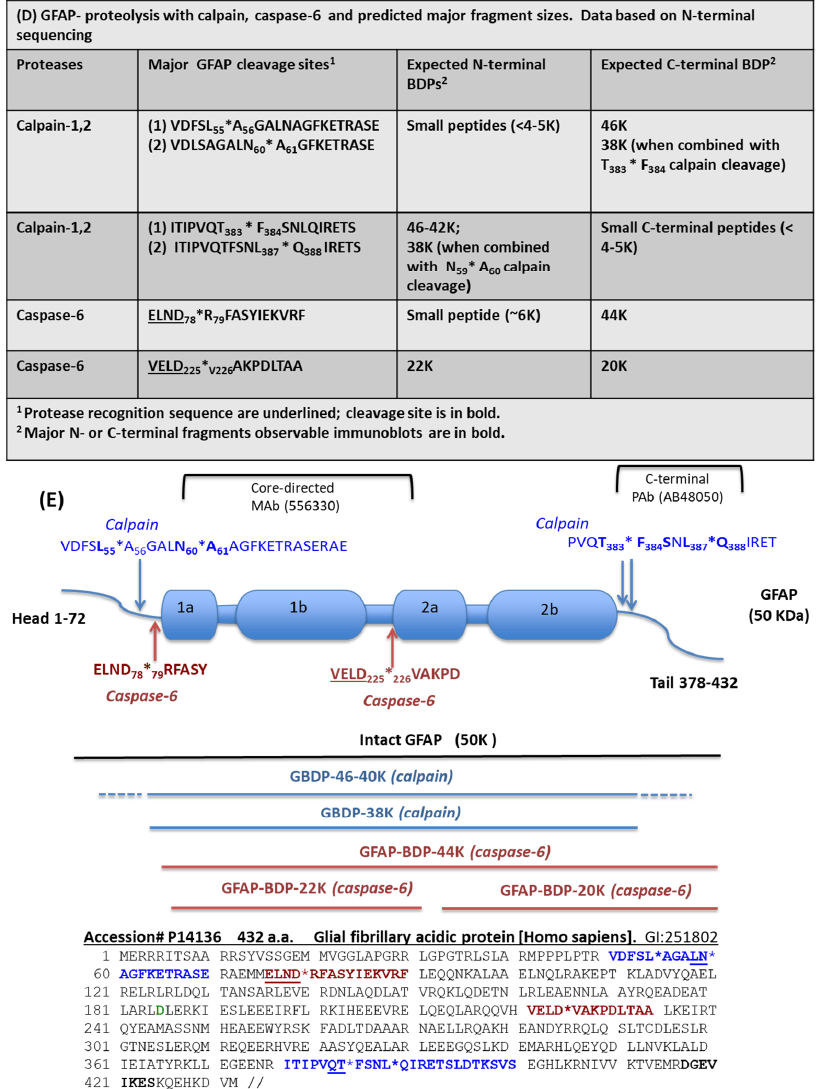
Figure 3. Digestion of purified GFAP by calpain-1 and caspase-6. Characterization with different GFAP antibodies and GBDP-specific antibodies by immunoblotting. ( A ) GFAP core Mab, ( B ) GFAP C-terminal Pab, ( C ) GBDP-specific antibody. ( D ) GFAP proteolysis with calpain, caspase-6, and predicted major fragment sizes. Data based on N-terminal sequencing. ( E ) Schematics of GFAP proteolytic fragment formation. The top panel shows GFAP linear model and major calpain/caspase-6 cleavage sites. The middle panel shows the positions of major fragments. The bottom panel shows the human GFAP amino acid sequence and the annotated cleavage sites (*) by calpain (blue), and by caspase-6 (red).